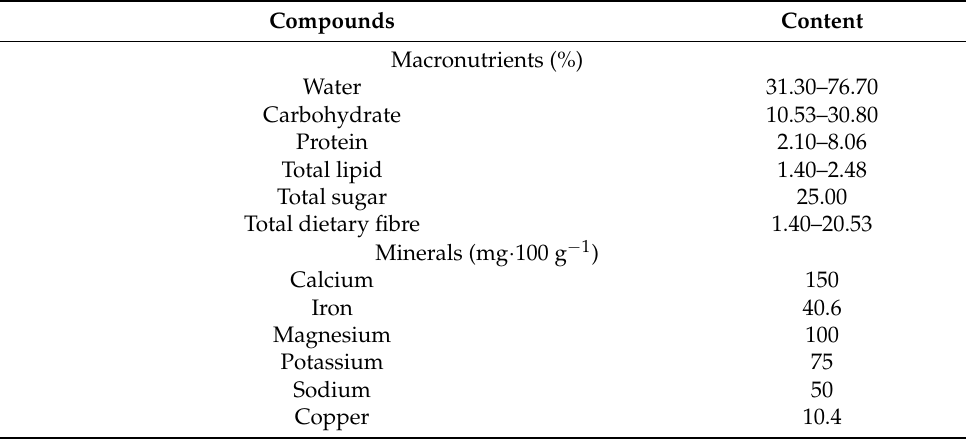
Table 2. Nutritional and phytochemical compositions of mango peel